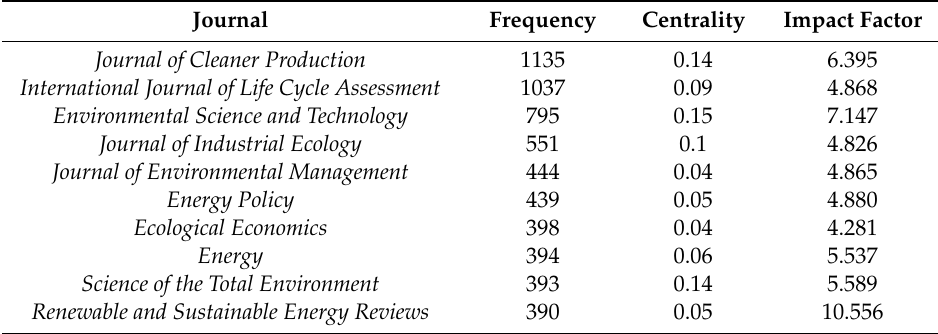
Table 6. Top 10 journals based on cited